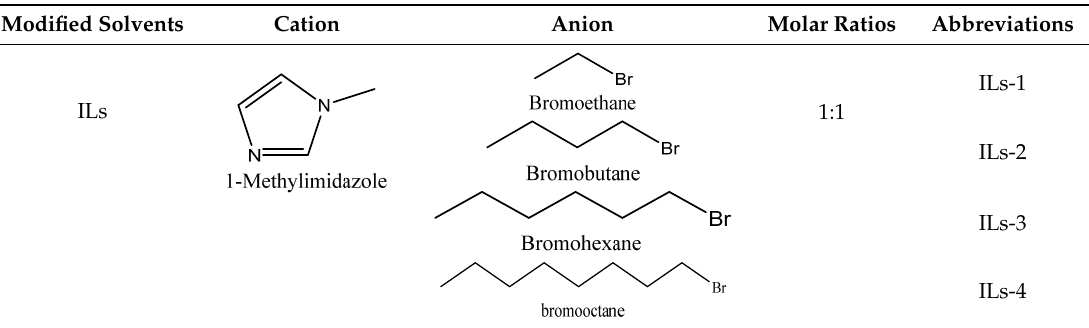
Table 4. Abbreviations of ILs as modified solvents.